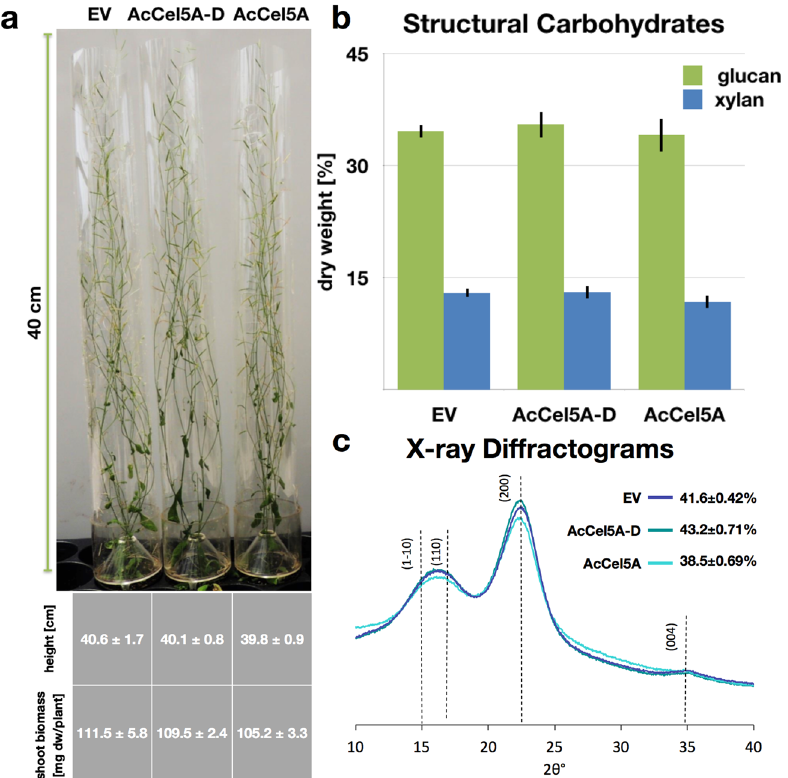
Figure 3. Plant growth, biomass accumulation, structural carbohydrate composition, and cellulose crystallinity. ( a ) Plant height and shoot biomass dry weight (dw) of wild-type empty vector control (EV), AcCel5A catalytically inactive (AcCel5A-D), and transgenic AcCel5A lines at a mid-senescence growth stage, ten weeks after germination. Values are presented as the mean ( ± SEM) of six measured plants. There are no significant differences in plant heights or masses among the plant lines. ( b ) Structural carbohydrate chemical composition shows no significant differences in major carbohydrate cell wall polymers among the three plant lines. ( c ) X-ray diffractograms from wild-type empty vector control (EV), AcCel5A catalytically inactive (AcCel5A-D), and transgenic AcCel5A stem samples. The crystallinity index values (CI) derived from the spectra are indicated. The AcCel5A-D data is from line 37-4-a and the AcCel5A data is from line